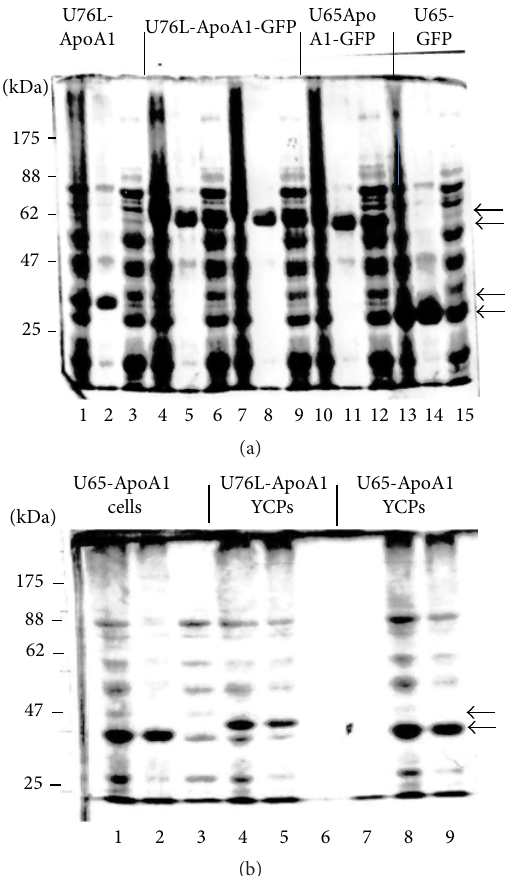
Figure 6: (a) SDS-PAGE of proteins from cells expressing the following: Lanes 1–3, U76L-ApoA1 (37.7kDa, arrow); Lanes 4–6 and 7–9, U76L-ApoA1-GFP (64.6 kDa, arrow); Lanes 10–12, U65- ApoA1-GFP(62.5 kDa,arrow);andLanes13–15,U65-GFP(34.1 kDa, arrow).Foreachset,thefirstlaneis3,000 × gsupernatant,thesecond is 16,000 × g pellet, and the third is 16,000 × g supernatant. (b) SDS- PAGE. Lanes 1, 4, and 8 are total proteins, Lanes 2, 5, and 9 are 200,000 × g pellets, and Lanes 3, 6, and 7 are 200,000 × g super- natants. Lanes 1–3 and 7–9, cells and YCPs, respectively, expressing U65-ApoA1 (35.6 kDa, arrow). Lanes 4–6, YCPs expressing U76L- ApoA1 (37.7 kDa,